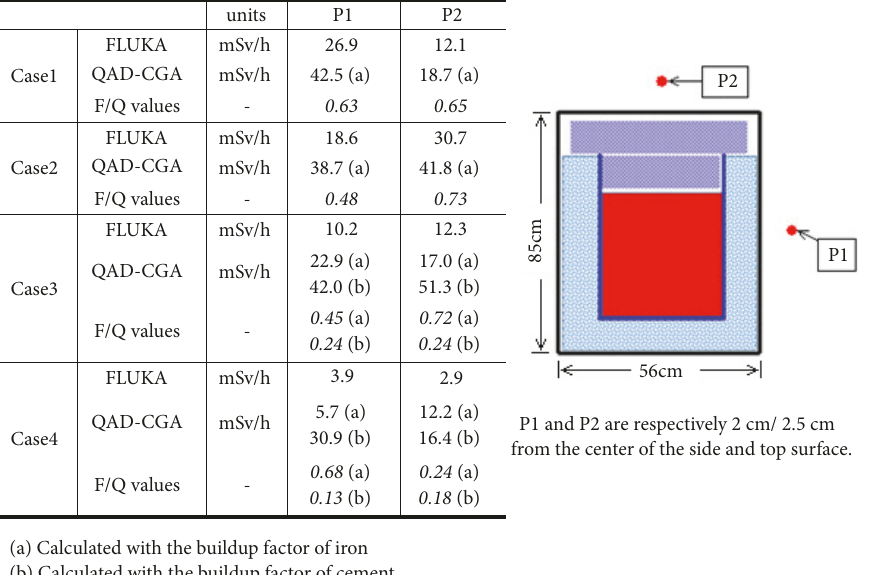
Figure10:CalculateddoseratesatthetwopointsofinterestbyFLUKAandQAD-CGA,andtheFLUKA’sresultscomparedtotheQAD-CGA’s (F/Q values).